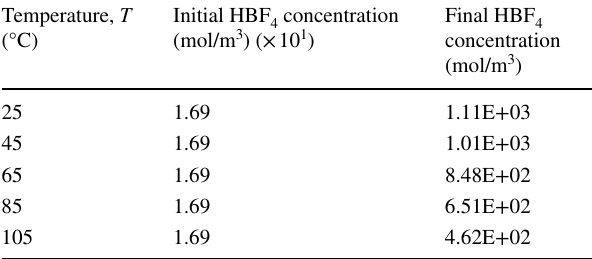
Table 5 Effect of temperature on HBF